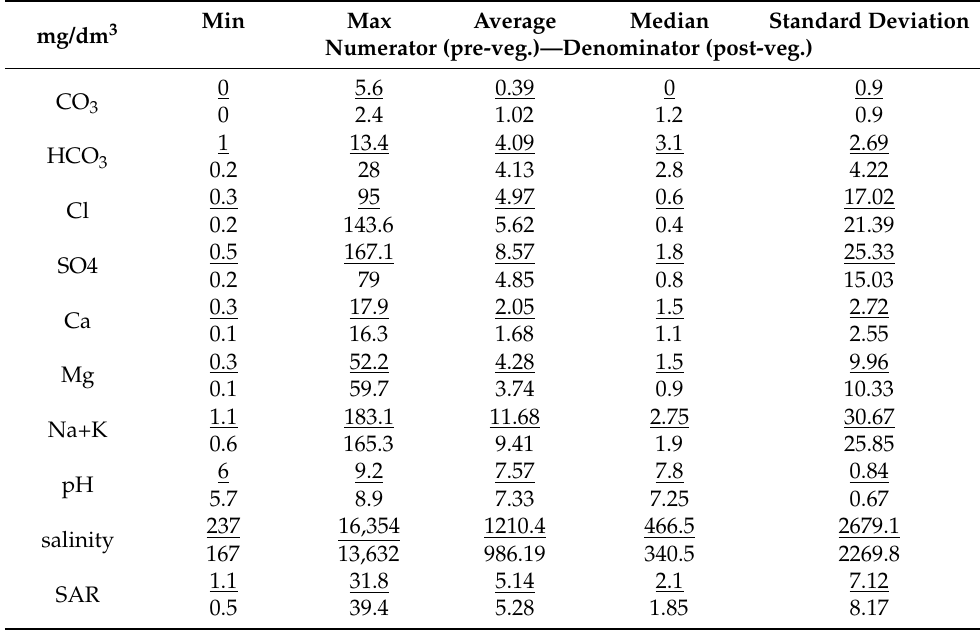
Table 3. Summary statistics for concentrations of chemical components. Min Max Average Median Standard Deviation mg/dm 3 Numerator (pre-veg.)—Denominator (post-veg.) CO 3